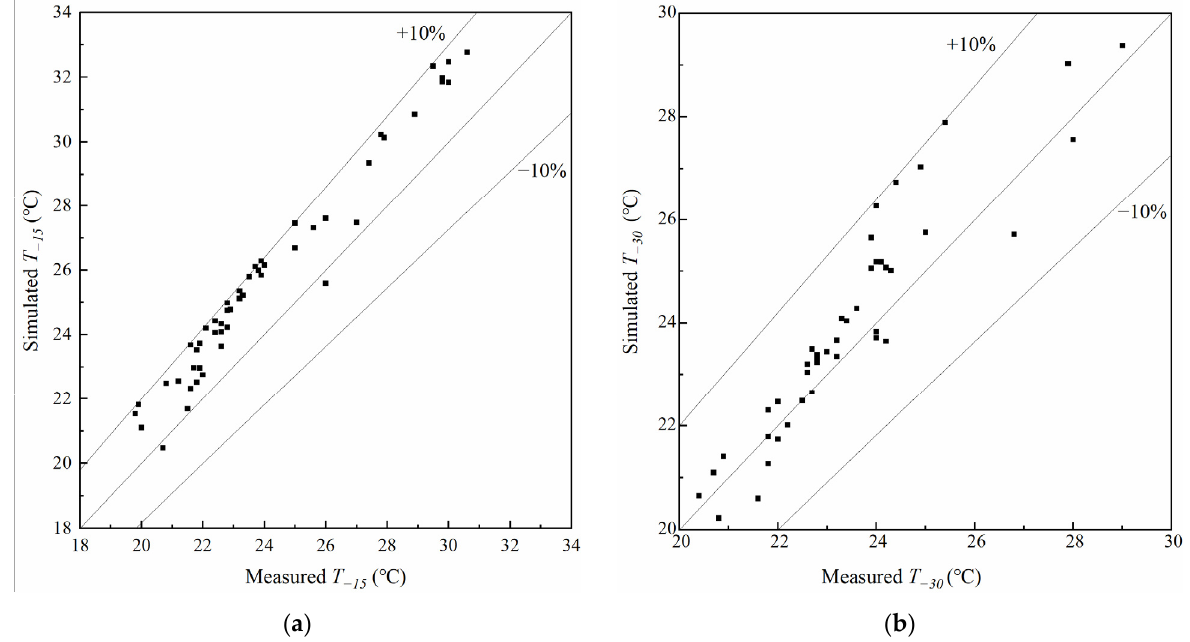
Figure 15. Measured and simulated soil temperatures during the transition season. ( a ) T − 15 and ( b ) T − 30 .